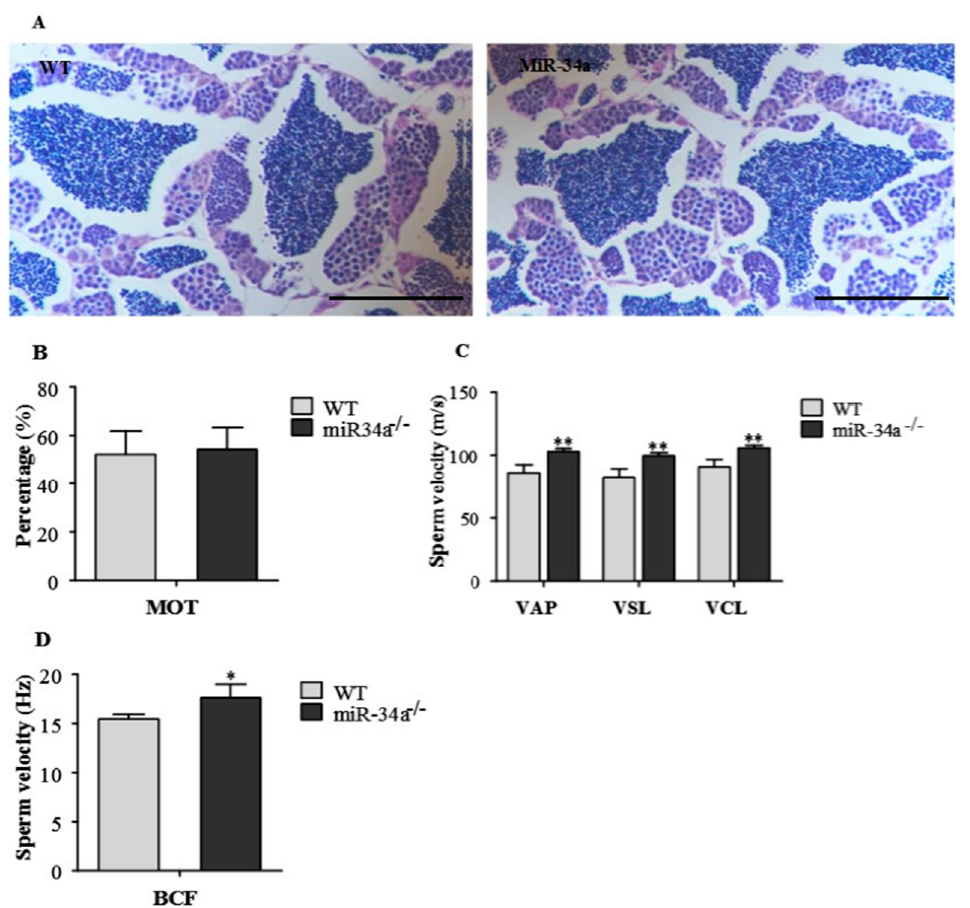
Figure 4. Testis morphology and sperm motility parameters between WT and miR-34a − / − zebrafish. ( A ) H&E staining of testicular tissue. Scale bar: 100 μ m; ( B ) Percentages of motile sperm for WT and miR-34a − / − zebrafish; ( C ) Sperm velocity parameters of progressive sperm for WT and miR-34a − / − zebrafish; ( D ) BCF of progressive sperm for WT and miR-34a − / − zebrafish. * p < 0.05 and ** p < 0.01.